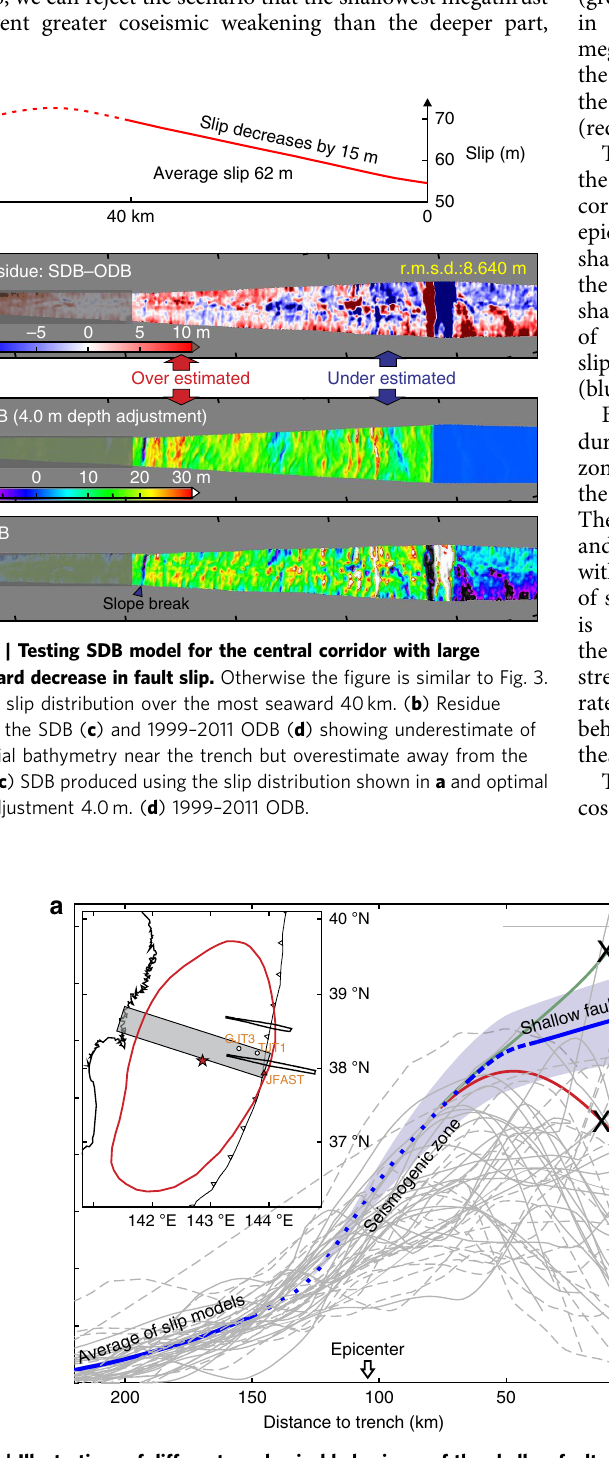
Figure 8 | Illustrations of different mechanical behaviours of the shallow fault and their resultant slip distributions along the main corridor rejected and supported by SDB modelling. ( a ) Comparison between the optimal shallow fault slip of this work (blue line) and the 45 published slip models shown in Fig. 1 (grey lines). The error range (blue shading) is based on models with r.m.s.d.’s o 8.55m (Fig. 4a). Dotted part of the blue line is a hand-drawn, poorly constrained smooth connection between the near-trench slip determined in this work and the slip further downdip based on an average of the 45 slip models. Slip scenarios represented by the green and red lines are not supported by the SDB analysis. ( b ) Schematic illustration of stress evolution of the shallowest fault segment. Red, green and the two blue curves represent mechanically different shallow fault behaviours, corresponding to lines of same colours in a . Blue curve 2 represents a more likely scenario in which delayed dynamic weakening 6,30 of the shallow fault occurred during the earthquake. ( c ) Similar to b but for the deeper seismogenic